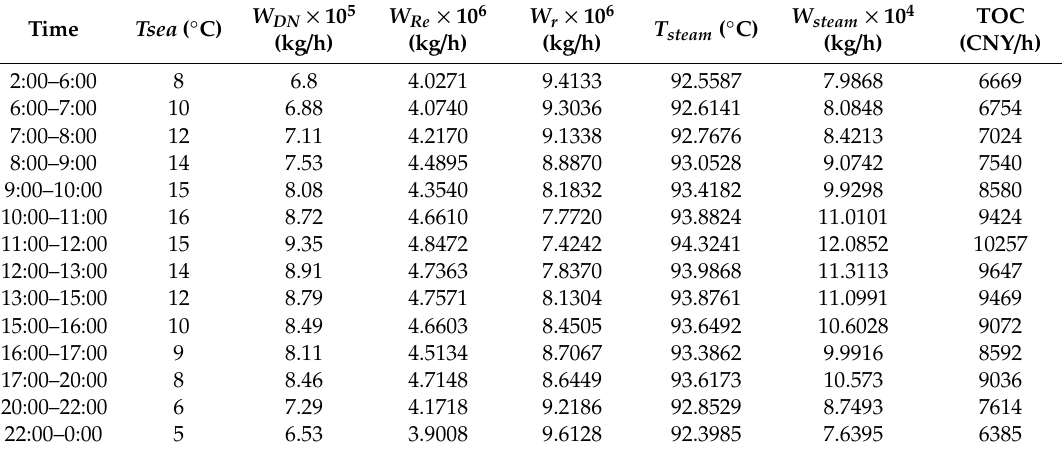
Table 7. States and optimal results obtained by solving